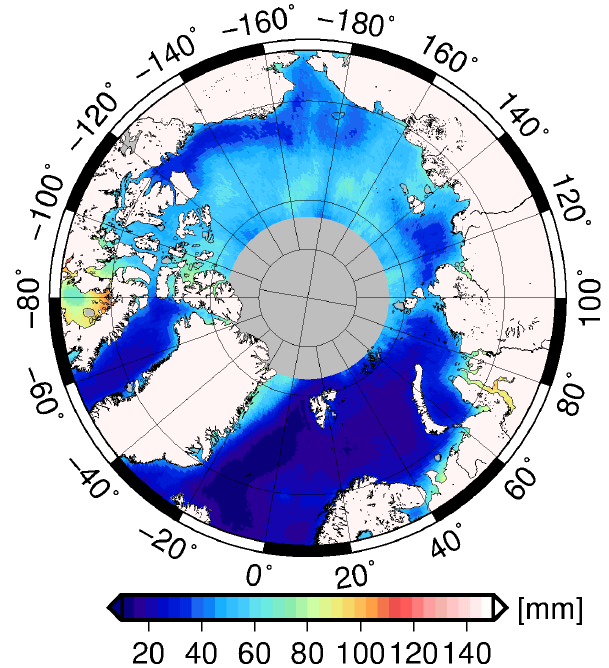
Figure 4. The total uncertainty of SLAs from the bootstrapping, given as the median SLA range between the 2.5% percentile to the 97.5% percentile (i.e., the 95% confidence level interval) of monthly data in the SLA product from September 1991 to September